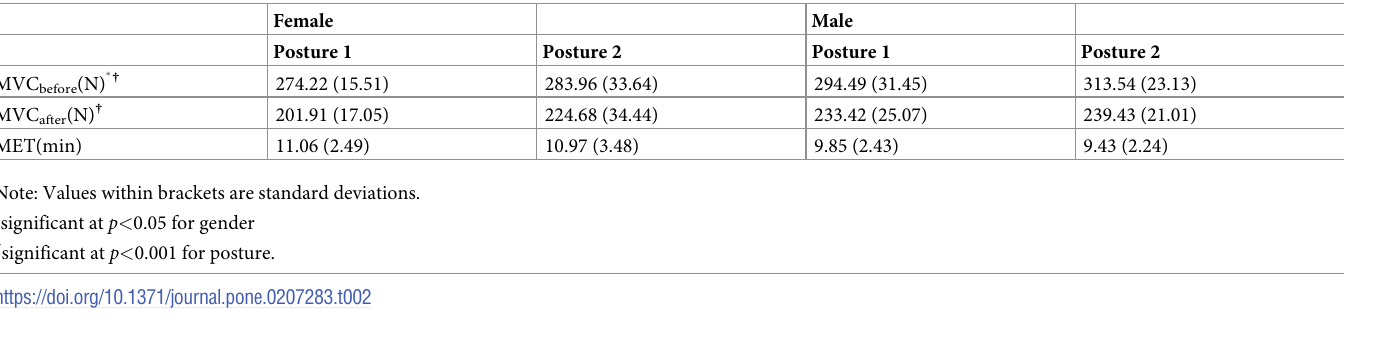
(304.02 N) was significant higher (F(1,60) = 13.73, p < 0.001) than those of females (279.09 N). Table 2. MVC before , MVC after and MET over gender and